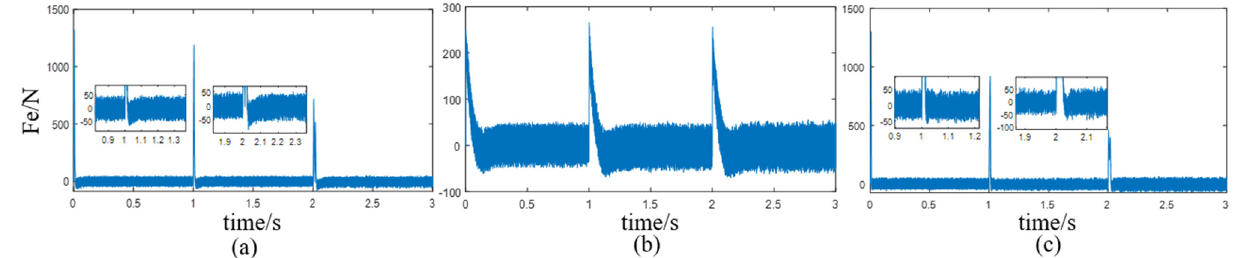
Figure 5. The thrust comparison of the three control system: ( a ) thrust change of the CT-SMC system; ( b ) thrust change of the PI control system; ( c ) thrust change of the SMC system.